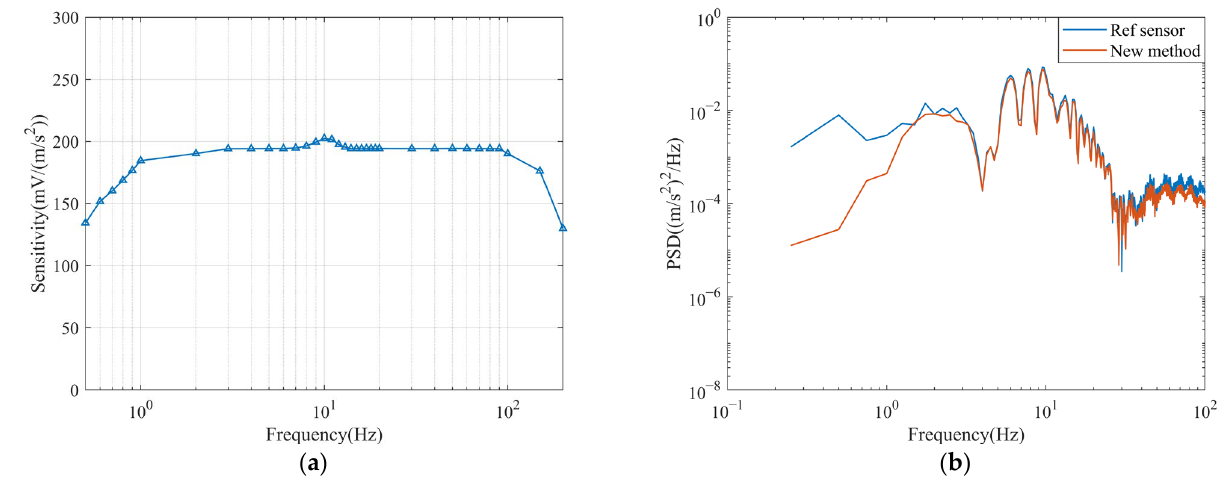
Figure 8. ( a ) Sensitivity curve of the system after improvement by the new method; ( b ) PSD of a segment of the real signal recorded with the reference sensor and the sensor compensated by the new method.